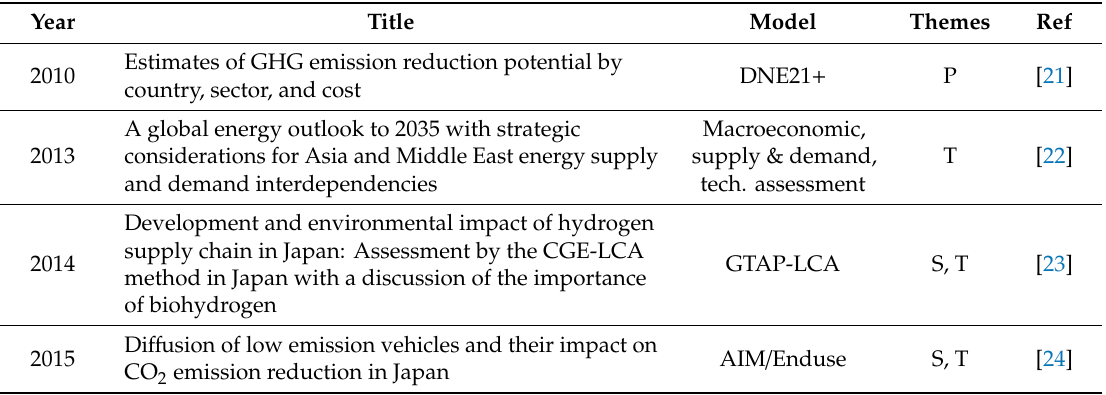
Table 2. Scholarship of energy system modeling reviewed in this study. Themes: S: Storage, G: Gas grid supplementation, P: Power generation, T: